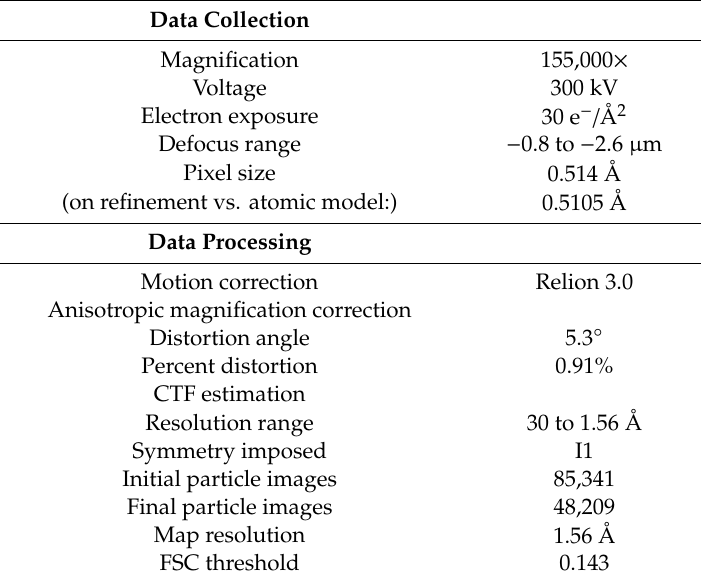
Table 1. Cryo-EM data collection and